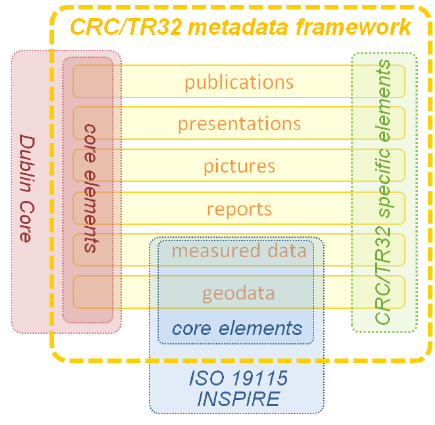
Figure 2. CRC/TR32 metadata